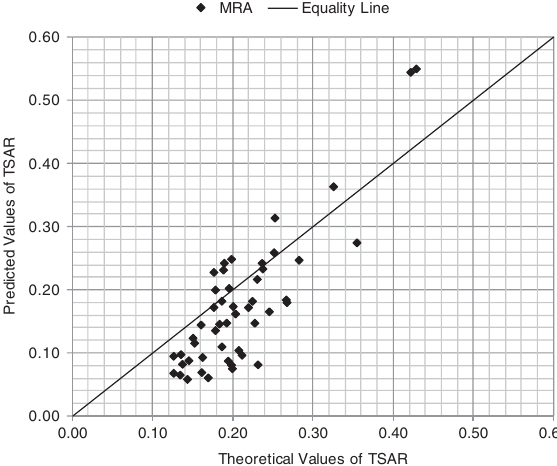
Fig. 14. Predicted P DF values by multiple nonlinear regres- sion vs. theoretical data (Set 2) Table 11. VFD system property combinations and corresponding responses using MRA & THA C (kN-s/m)